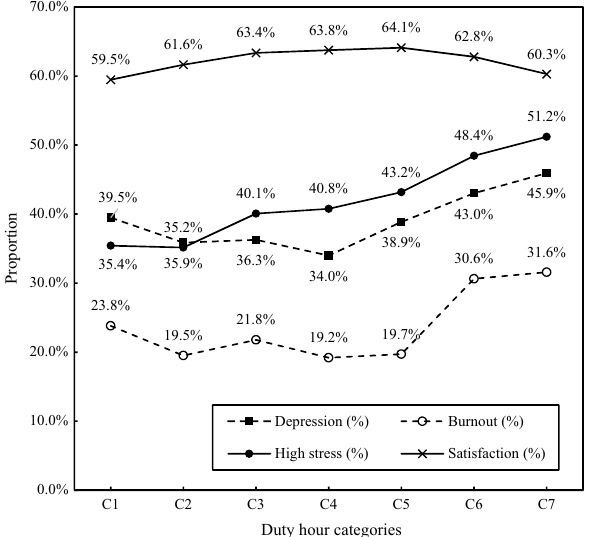
Figure 1. The association between duty hours and psychological health-related outcomes. Note Figure shows that depression, burnout, and high stress among residents appeared to increase with DHs; however, this was not associated with satisfaction. The categories of resident duty hours weekly were: Category 1 (< 50), Category 2 (≥ 50 and < 60), Category 3 (≥ 60 and < 70), Category 4 (≥ 70 and < 80), Category 5 (≥ 80 and < 90), Category 6 (≥ 90 and < 100), and Category 7 (≥ 100). Abbreviations: C1–C8 = Category 1 to Category